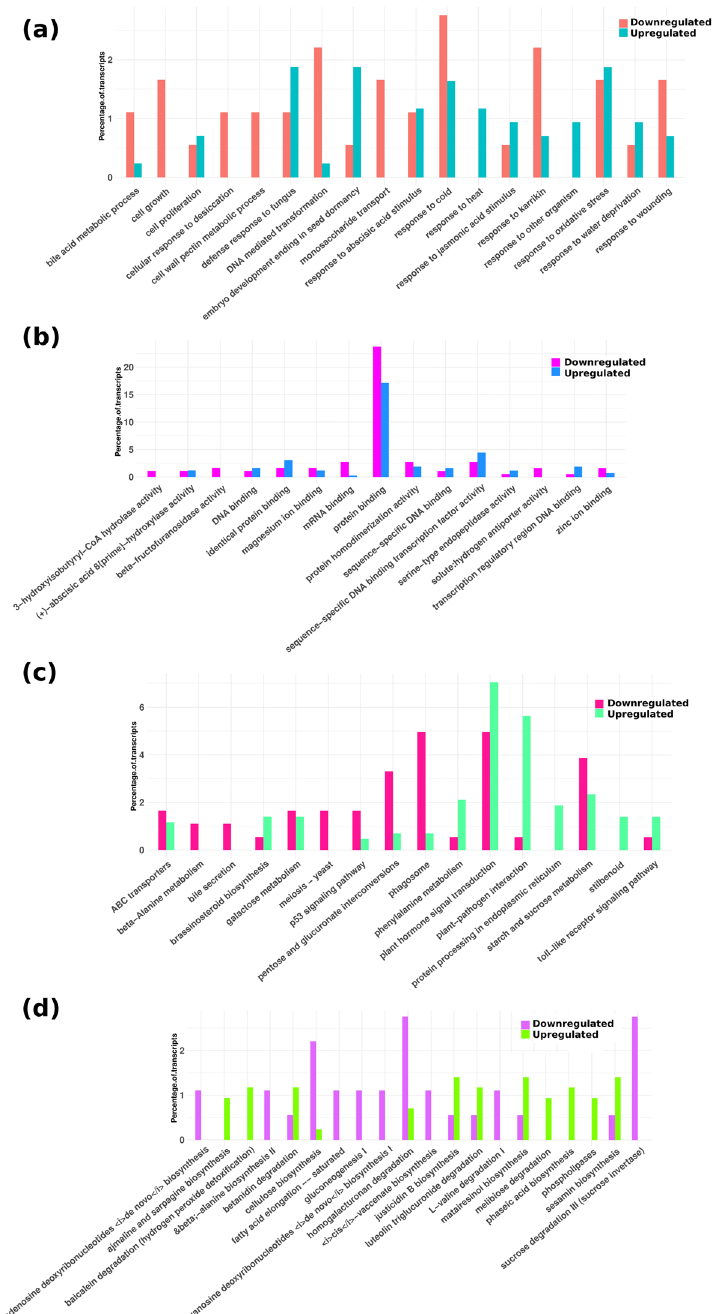
Figure 5. miRNA controlled genes abundance in different categorical annotations in rhizome tissue ( a ) biological process in R25/R15 ( b ) molecular function in R25/R15 ( c ) KEGG pathways in R25/R15 ( d ) PMN pathways in